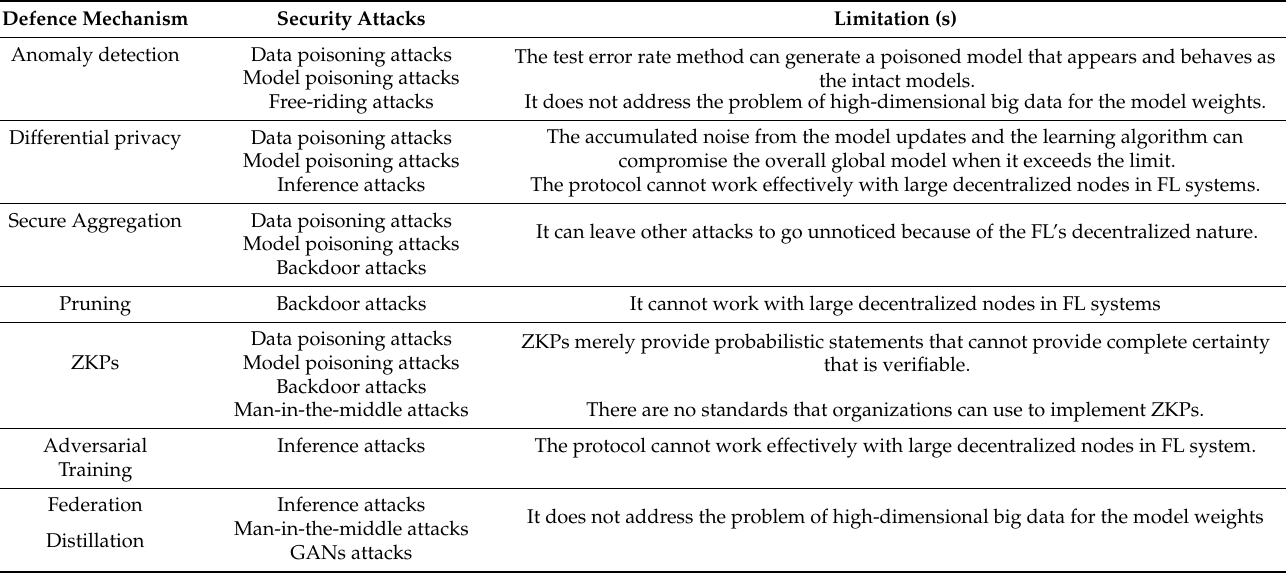
Table 1. Summary of defence mechanisms against security attacks in FL systems and their